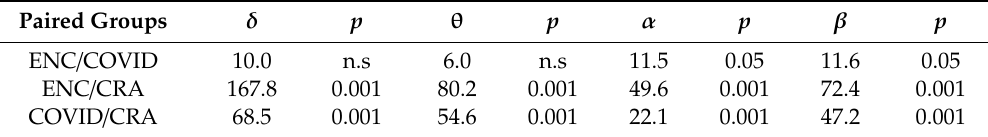
Table 1. Comparison by paired groups of patients of EEG bands using χ 2 . Statistical significance for 5 degrees of freedom is indicated by p in the column to the right of every band.